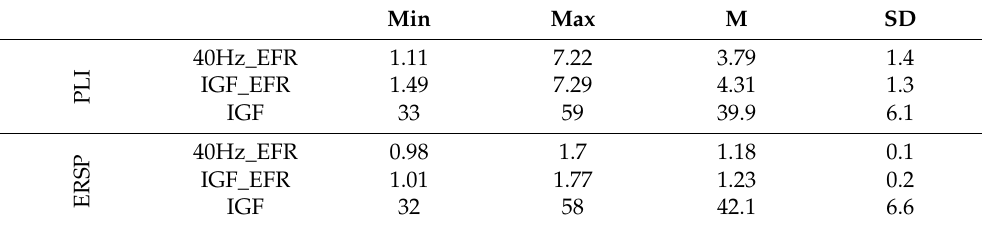
Table 2. Descriptive statistics for Envelope-Following